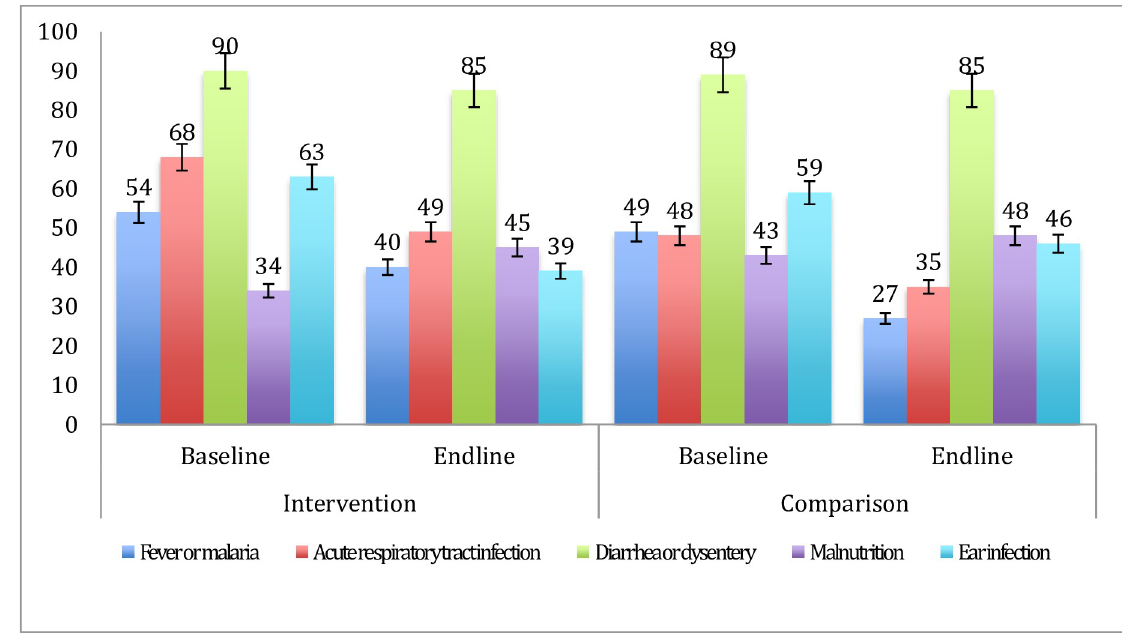
Fig 2. Sensitivity of the health extension workers’ disease classification among 2–59 months of age children at baseline (December 2016- February 2017) and endline surveys (December 2018-February 2019) in intervention and comparison areas.